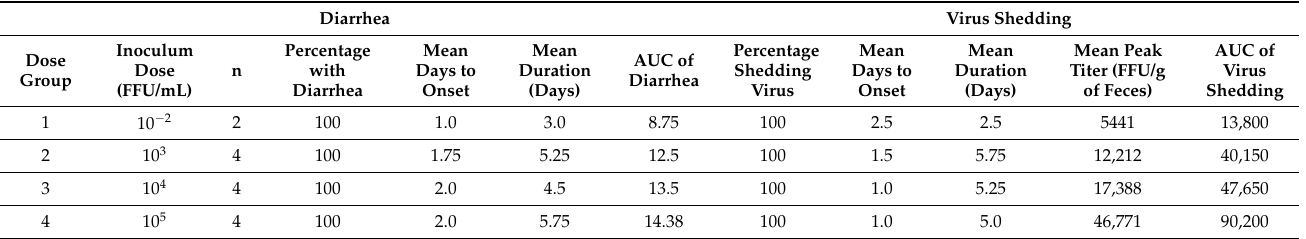
Table 2. HRV fecal shedding and diarrhea after inoculation of Gn pigs with different doses of Arg HRV